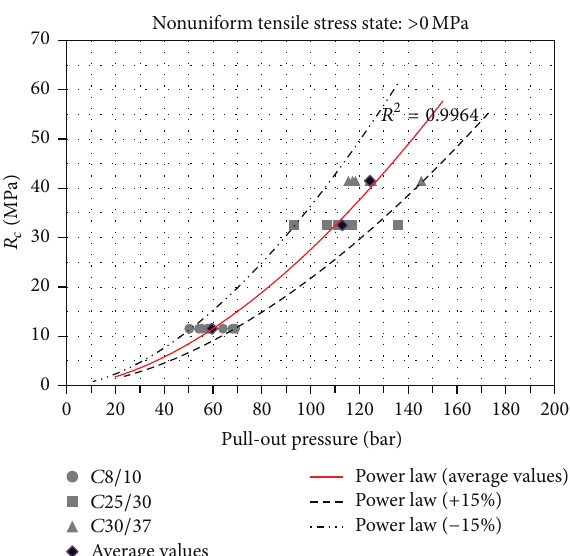
Figure 12: Calibration curve for 10MPa uniform compression stress.